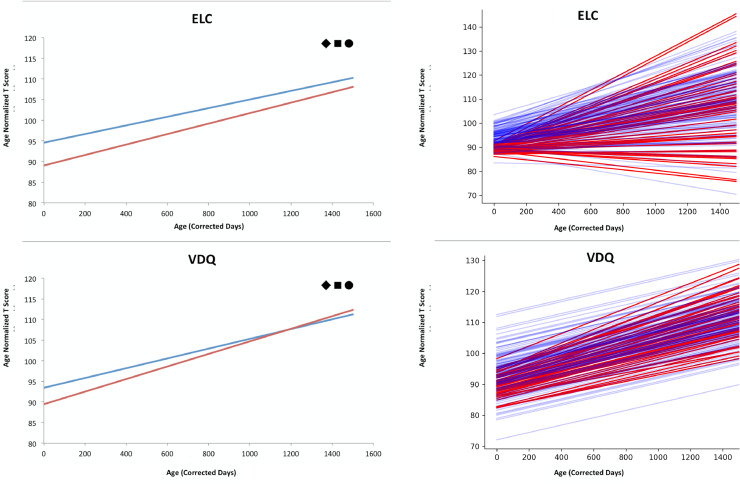
Longitudinal cognitive maturation trajectories of ELC, and VDQ. Carrier trajectories are denoted in red and non-carrier trajectories are displayed in blue. ◆ indicates a significant difference in baseline cognitive performance (p < 0.05, corrected for multiple comparisons), a • indicates that the Mullens composite score in our cohort showed a significant rate of change relative to the normal sample in the cognitive development model (p < 0.05, corrected for multiple comparisons), and a ■ indicates a significant difference in rate of cognitive development between APOE ε4 carriers and non-carriers (p < 0.05, corrected for multiple comparisons). NVDQ is not shown in this figure because this metric did not demonstrate a significant rate of change in our cohort relative to the normal sample. Adjacent to the population trajectories are individual trajectories of longitudinal cognitive development for ε4 carriers and non-carriers with carrier trajectories displayed in red and non-carrier trajectories displayed in blue.